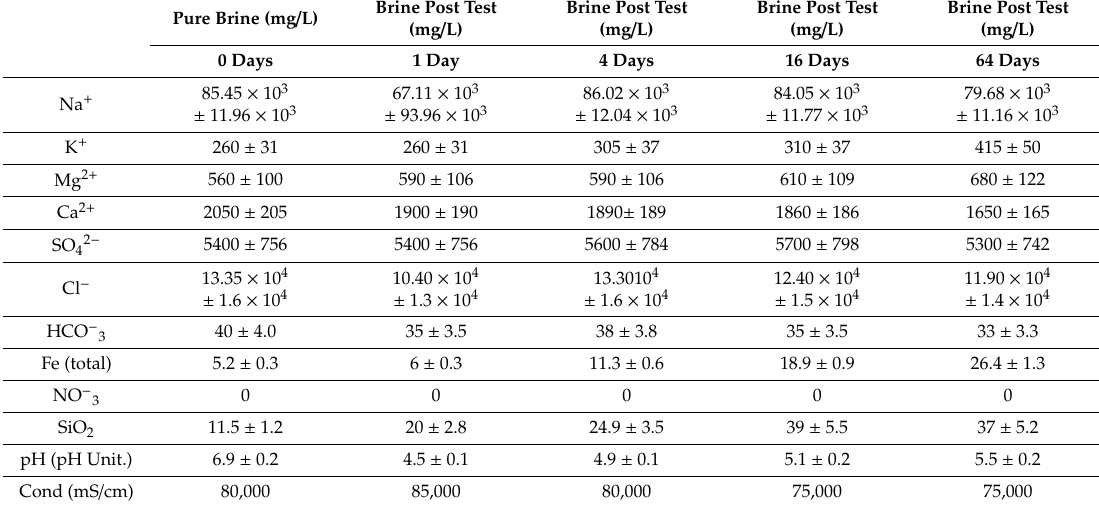
Table 6. Chemical analysis of pure brine and brine taken from the reaction chambers (one, four, 16 and 64 days) for Experiment 1 with CG (Figure S1 as supplementary material).